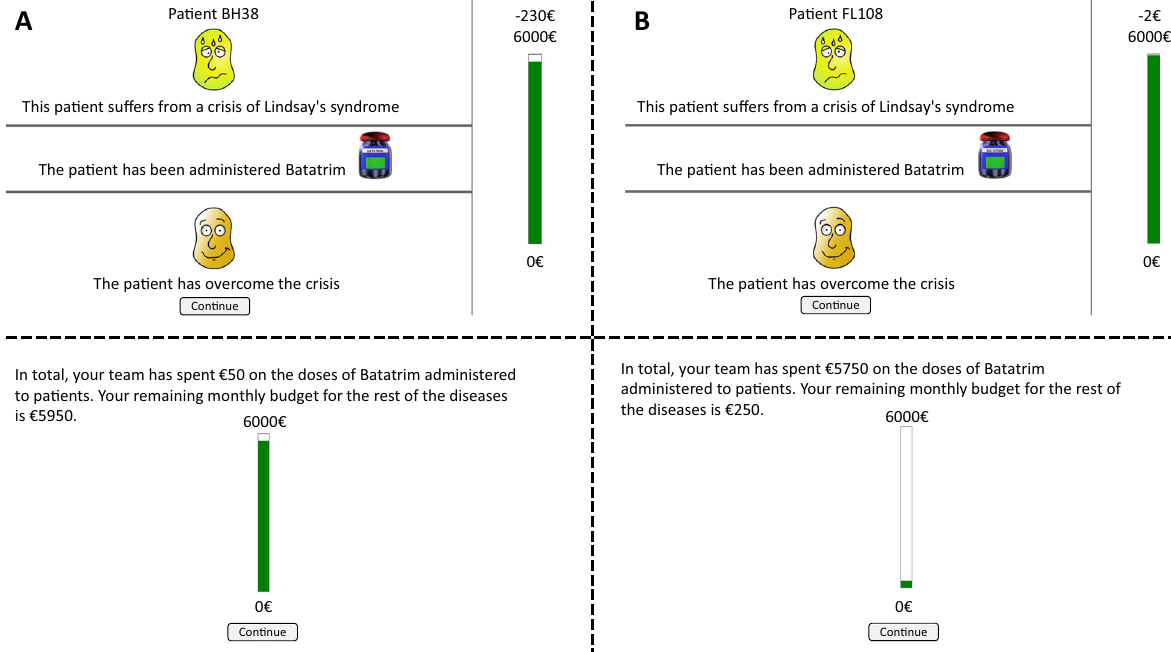
Fig. 1 Examples of the individual trials in both the expensive ( A ) and inexpensive ( B ) groups (above), as well as the final budget (below)